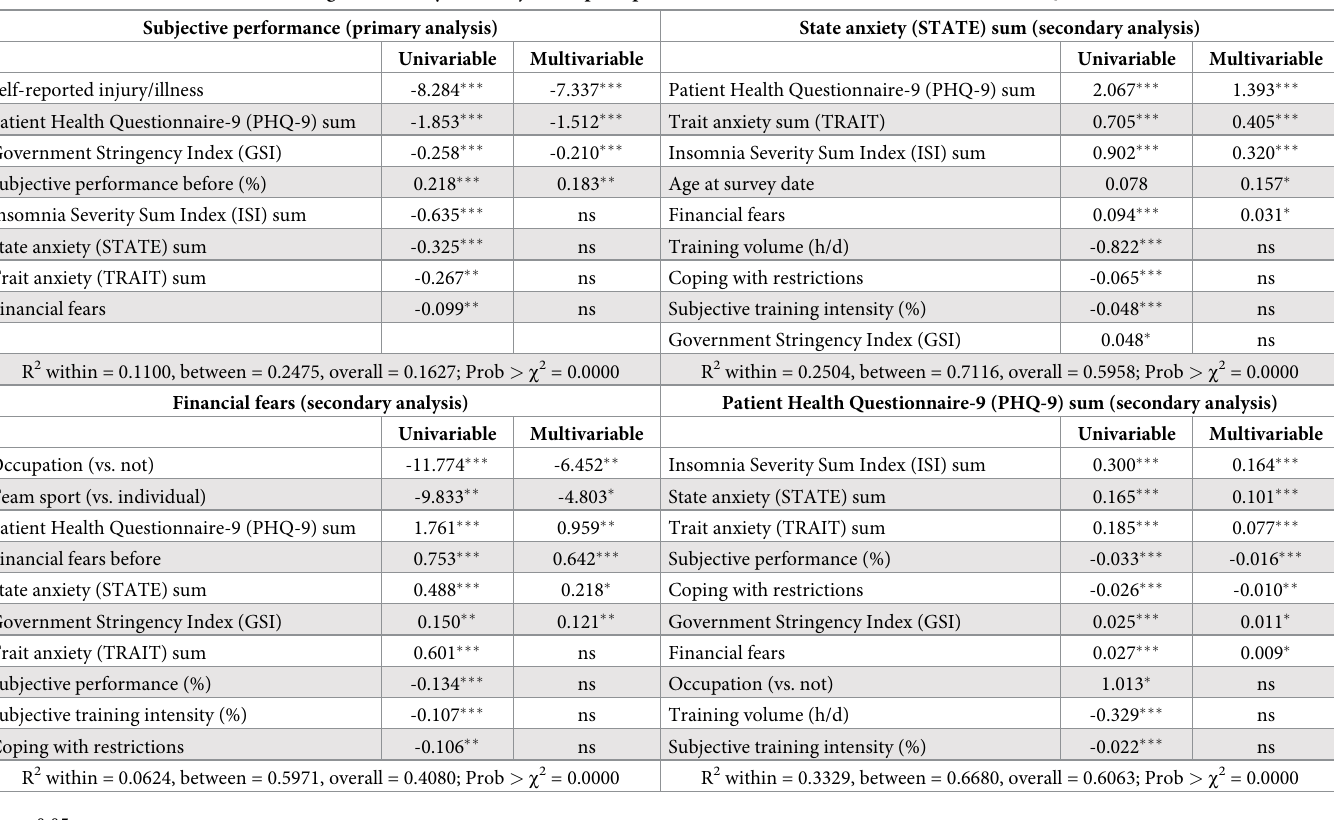
Table 2. Multivariable and univariable regression analysis of subjective sports performance, financial fears, STATE sum and PHQ-9 sum. Subjective performance (primary